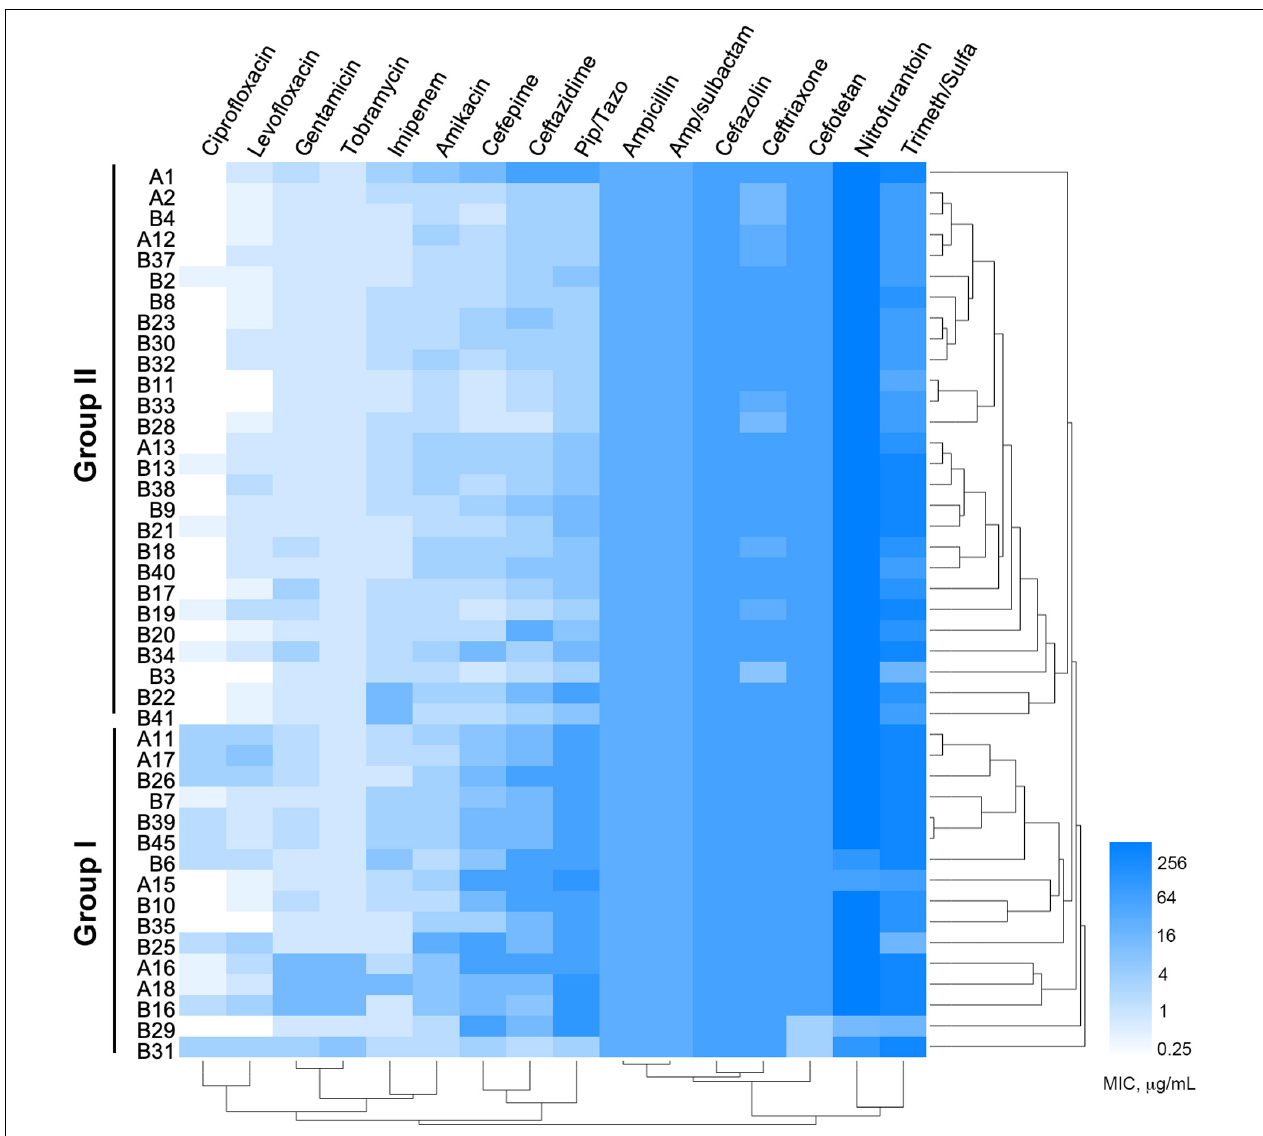
FIGURE 1 | Minimum inhibitory concentrations (MICs) of 16 commonly used antibiotics on Pseudomonas aeruginosa isolates from COPD patients. Bar, MIC values ( µ